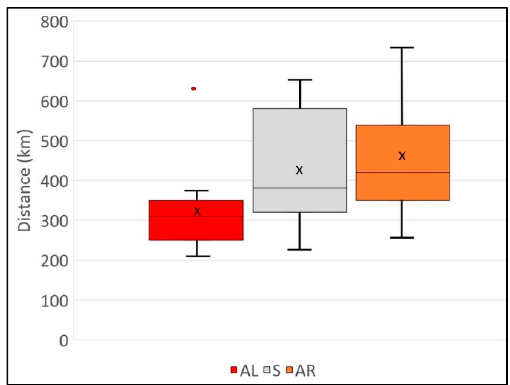
Figure 11. Boxplots for the distance to the TPW contour line of 40 mm at t00 by the rainfall distribution pattern. The X demarcates the mean value. The circle denotes a value at least 1.5 times the interquartile range.